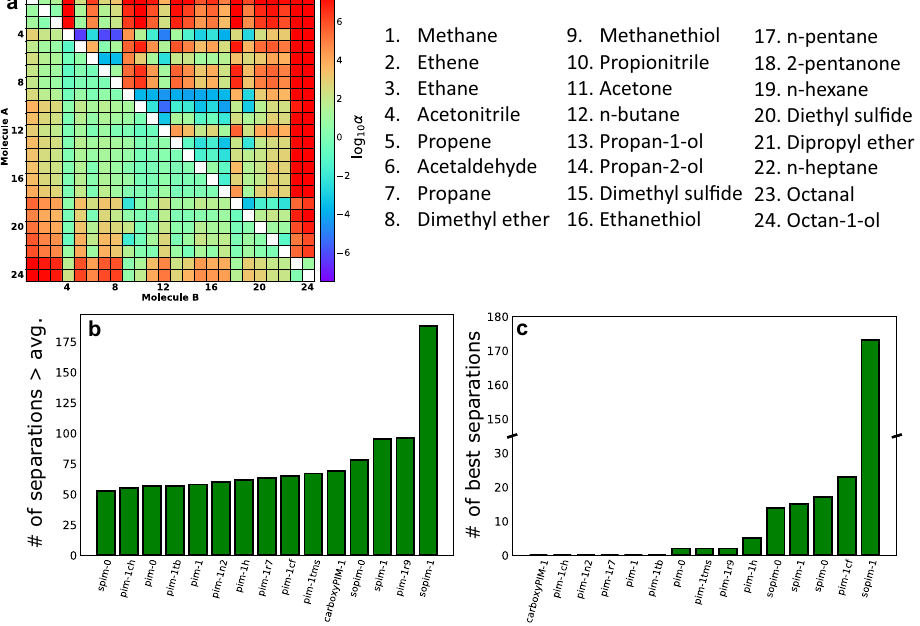
Fig. 6 Evaluation of room temperature separation ( α ) performance for 15 PIMs with 253 adsorbate binary pairs. a α matrix (log 10 scale) with the best performing separations across the 15 PIMs shown above the diagonal and the worst performance shown below. The bluer/ redder the color the better the separation performance. b Histogram of the frequency a given PIM ’ s separation performance is above the average of the 15 PIMs. c Histogram of the frequency a given PIM appears as the top performer for a binary adsorbate mixture.